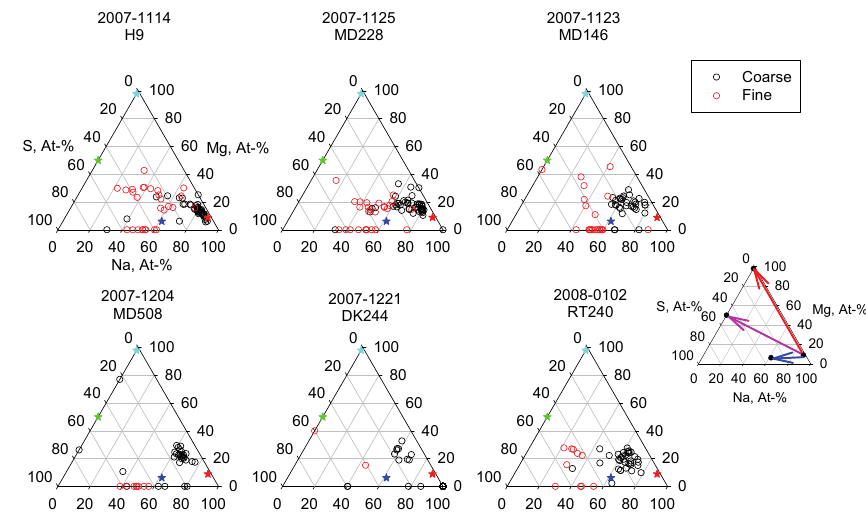
Fig.13 Figure 13. Ternary plots (Na-Mg-S) of sea-salt particles in coarse and fine modes during the JASE traverse. Red, blue, cyan, and green stars